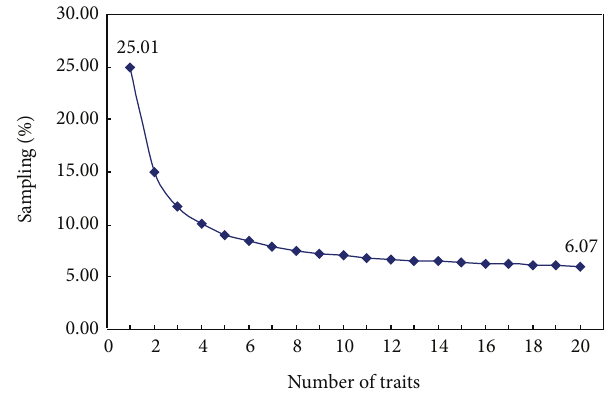
Figure 3: The relation curve of the sampling percentage and the number of traits when CR’s value was set to 80%. 25.01 and 6.07 were the optimal sampling percentage (%) when the number of traits was 1 and 20,